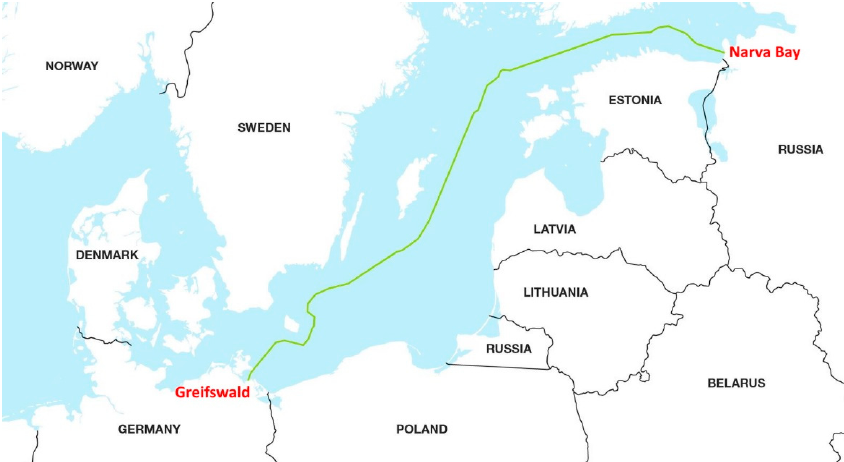
Figure 3. Nord Stream 2 pipeline. Source: Nord Stream 2 [98].